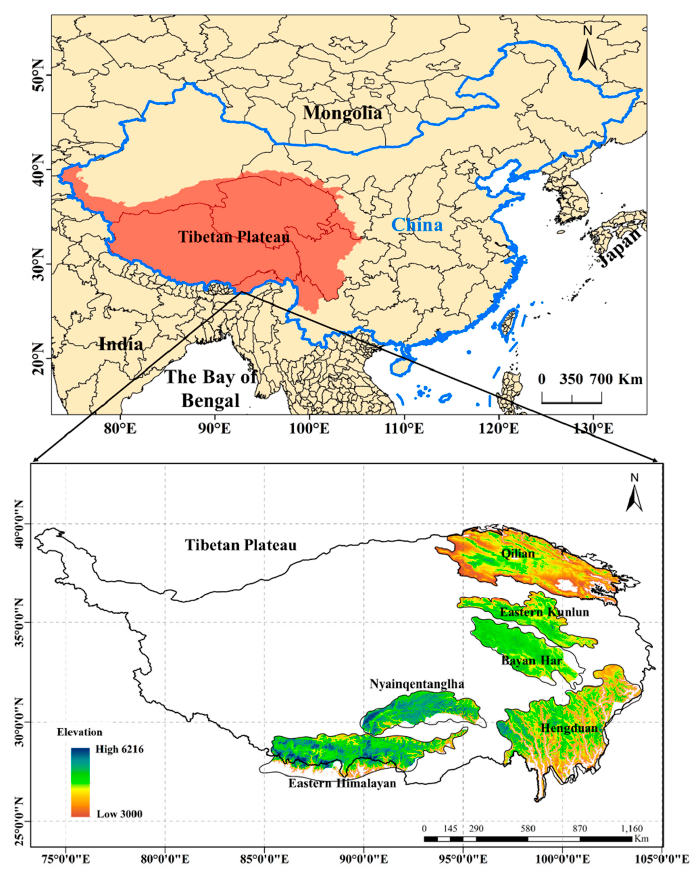
Figure 1. Top: the geographical location of the Tibetan Plateau; bottom: the spatial distribution of the six mountainous regions investigated in this study (i.e., the Qilian, Eastern Kunlun, Bayan Har, Nyainqentanglha, Eastern Himalayan, and Hengduan mountainous regions).